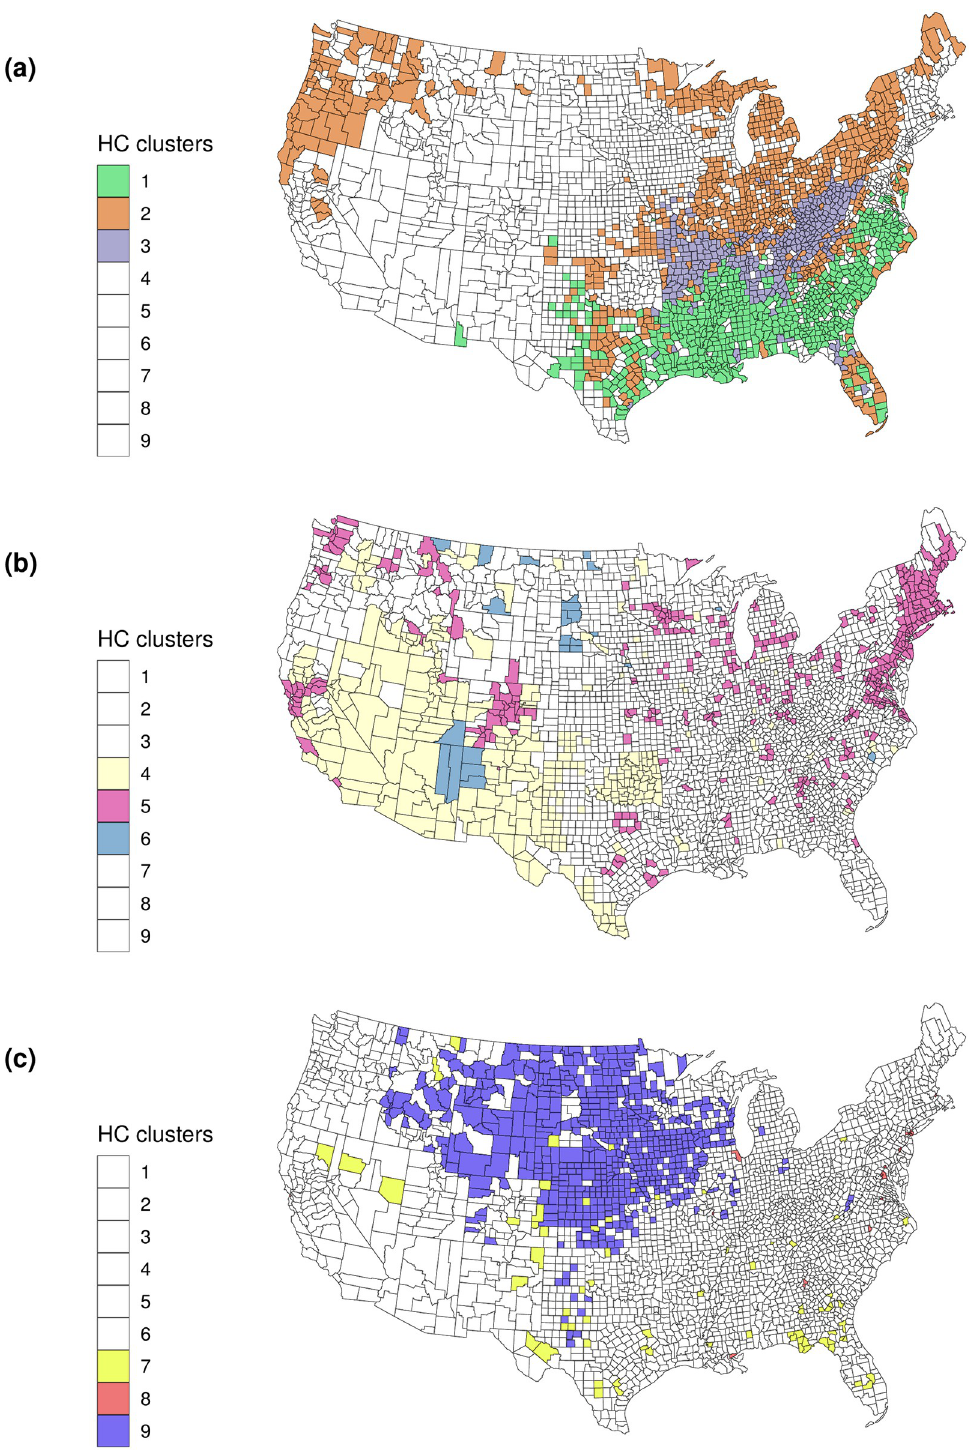
Fig 5. Conterminous US with county-level cluster